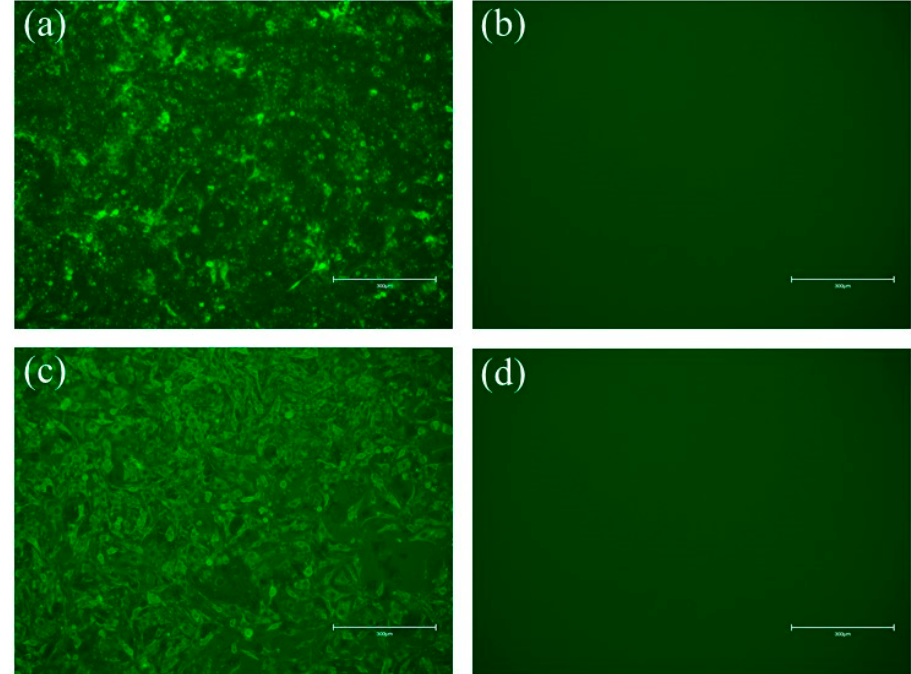
Figure 2. Identification of the recombinant viruses rSRV9-H and rSRV9-F via direct immunofluorescence. Cells were labeled with FITC-labeled mouse anti-RABV N protein monoclonal antibody at a 1:200-fold dilution. ( a ) Recombinant virus rSRV9-H, ( b ) negative control, ( c ) recombinant virus rSRV9-F, ( d ) negative control. Observation was performed using a fluorescence microscope.